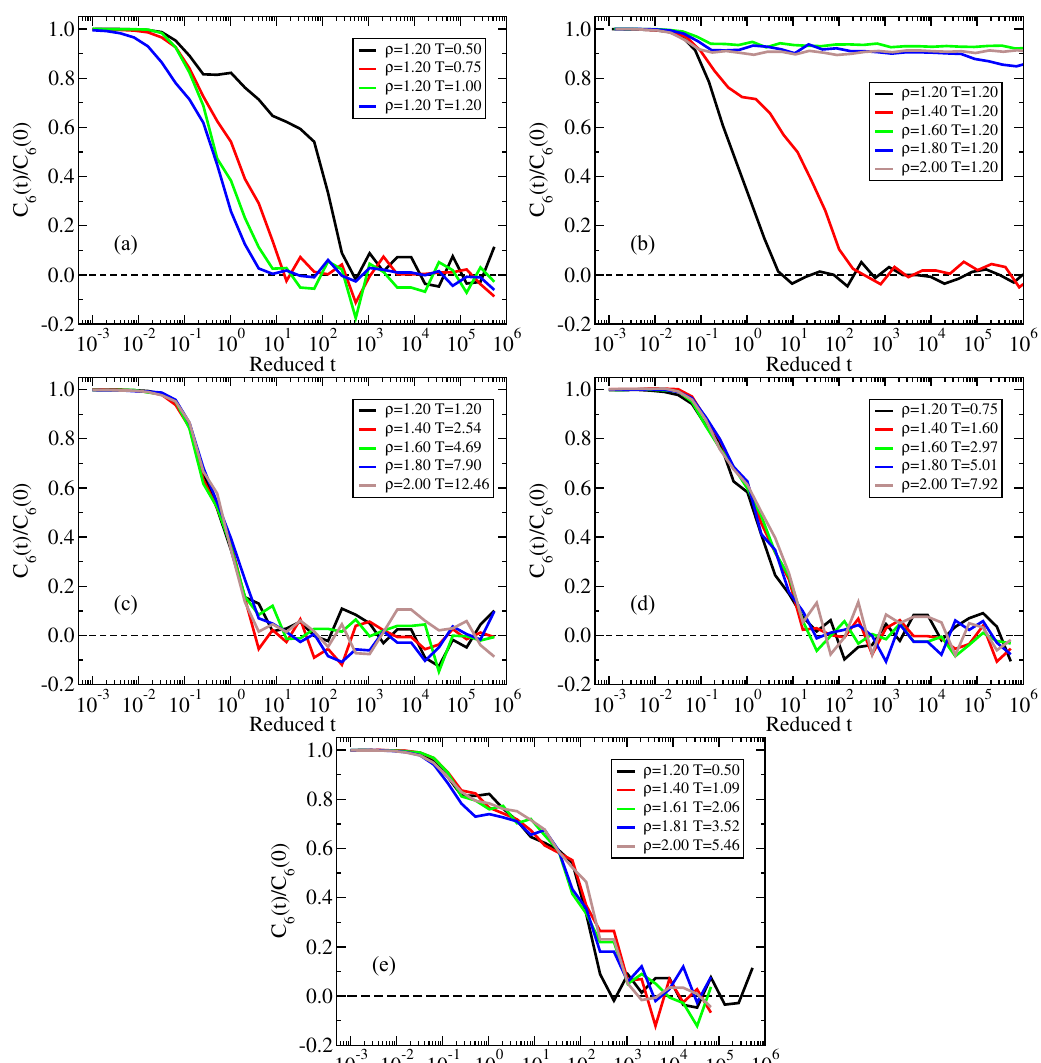
Figure 8. Normalized time-autocorrelation function of ¯ Q 6 ( t ) plotted as a function of the reduced time. ( a ) Results along the ρ = 1.20 isochore. ( b ) Results along the T = 1.20 isotherm. ( c ) Results along the reference-state-point ( ρ , T ) = ( 1.20,1.20 ) isomorph. ( d ) Results along the reference-state-point ( ρ , T ) = ( 1.20,0.75 ) isomorph. ( e ) Results along the reference-state- point ( ρ , T ) = ( 1.20,0.50 ) isomorph. There is good isomorph